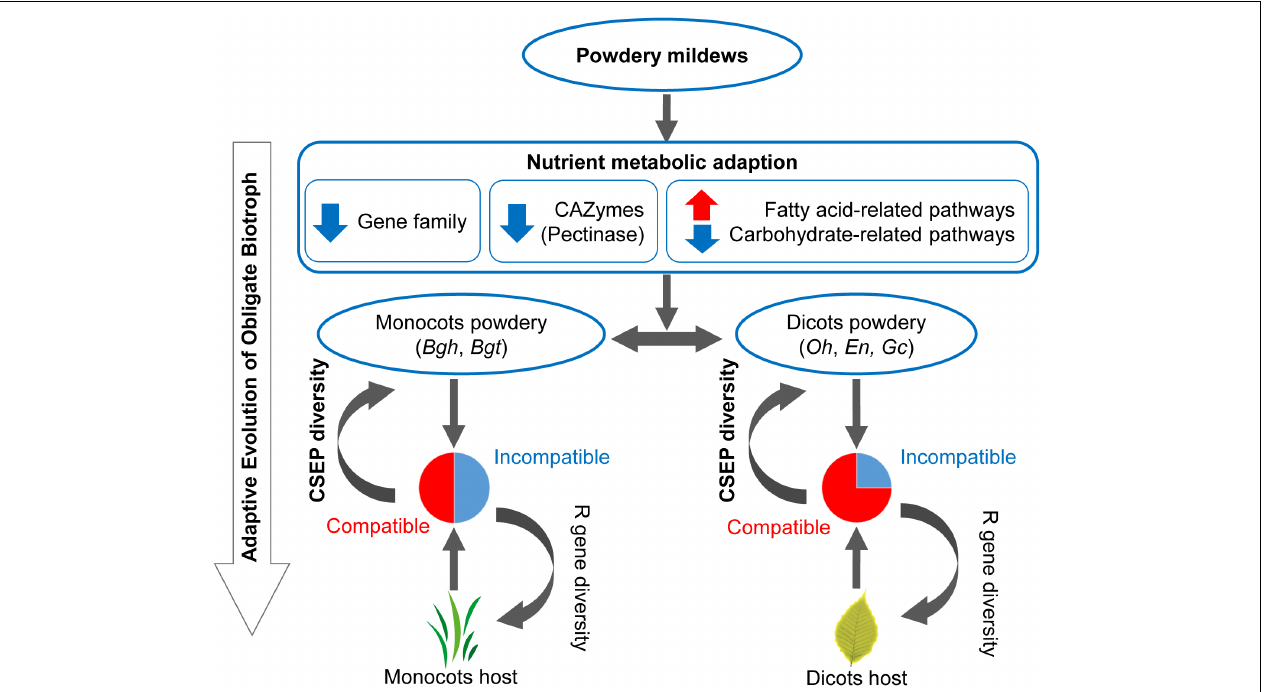
FIGURE 7 | Evolutionary model of inefficient carbohydrate metabolism pathway and diverse CSEPs enables an adaptation to an obligate biotrophic lifestyle. Red arrows indicate gene family/pathway expansion. Blue arrows indicate gene family/pathway contraction. Pie plots indicate common incompatible interactions between monocot powdery mildews and monocot plants and infrequent incompatible interactions between dicot powdery mildews and dicot plants. CSEP, candidate secreted effector protein. R gene, plants’ resistance